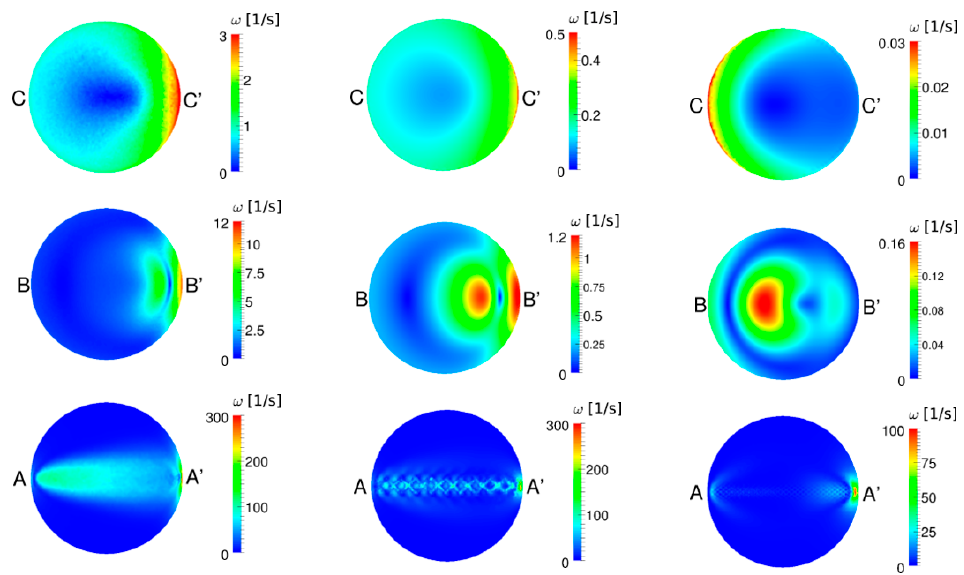
Figure 9. Vorticity contour at different cross-sections of the ( left ) UA, ( center ) RS, and ( right ) FD at late diastole.